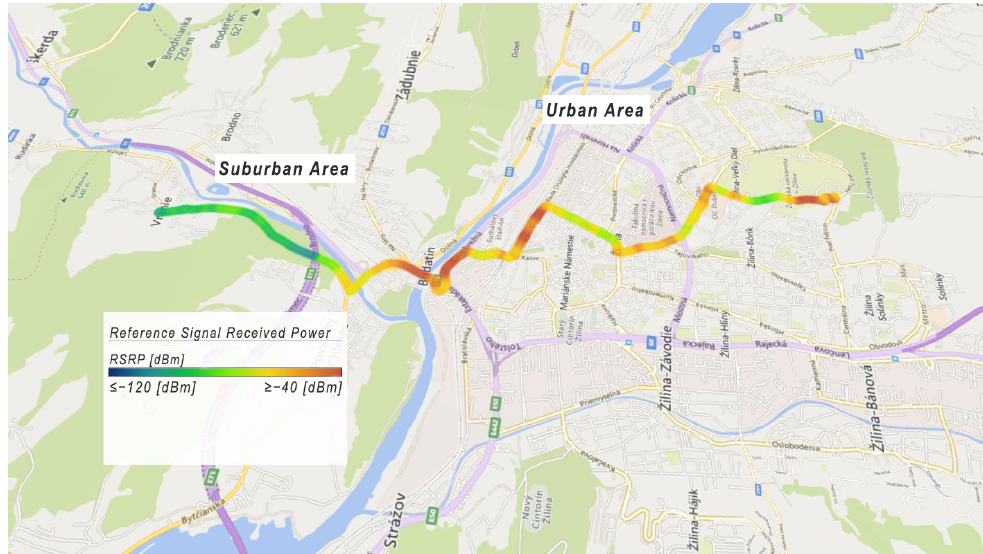
Figure 15. Example of Reference Signal Received Power.